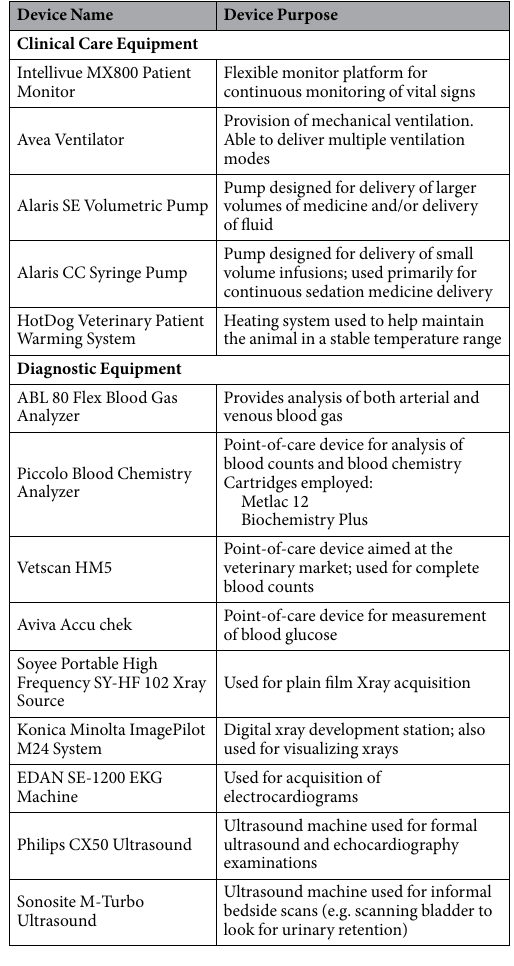
Table 1. Clinical Care and Diagnostic Equipment List. Listing of clinical and diagnostic equipment used during this